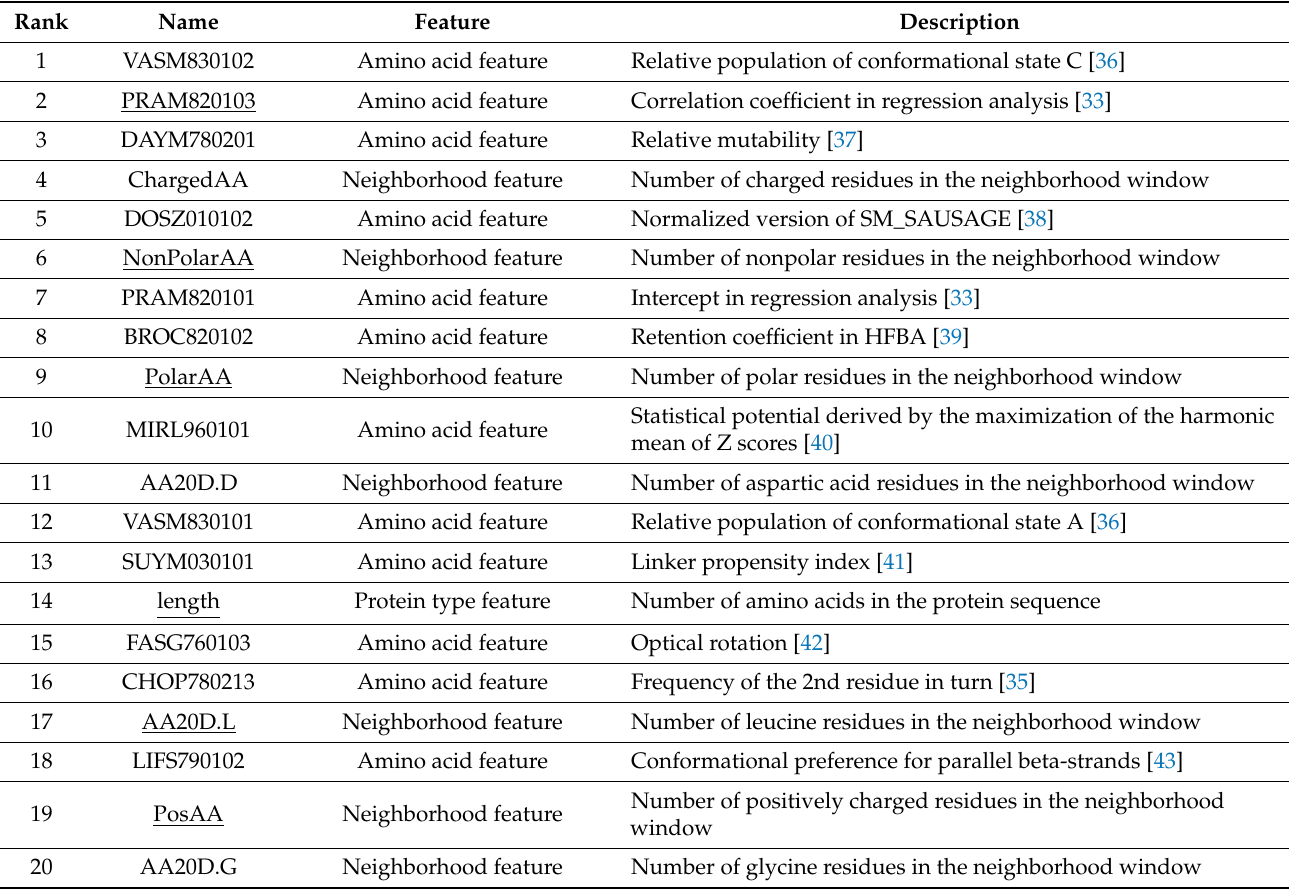
Table 3. Features selected by RFE for two-layer three-class LightGBM increasing/no effect classifier sorted by importance. Features shared by to the two predictors are